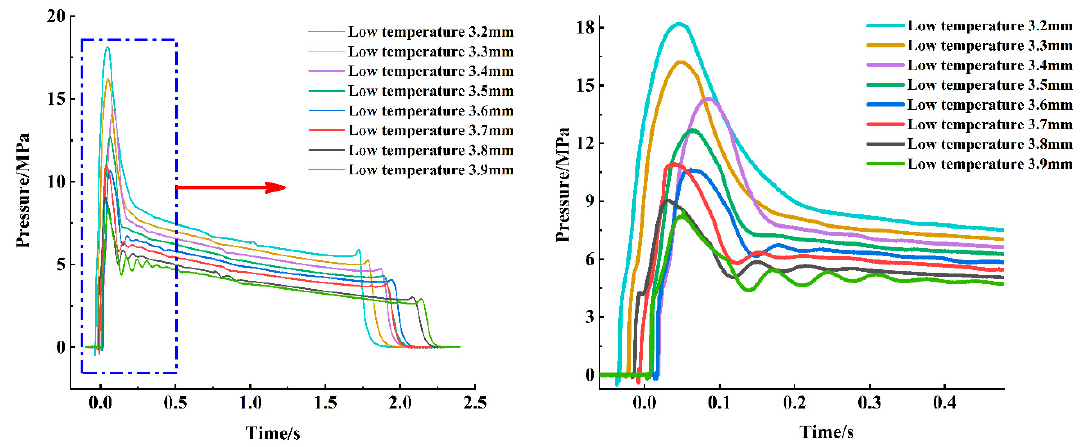
Figure 11. Experiment of different nozzles of the pyrotechnic igniter.